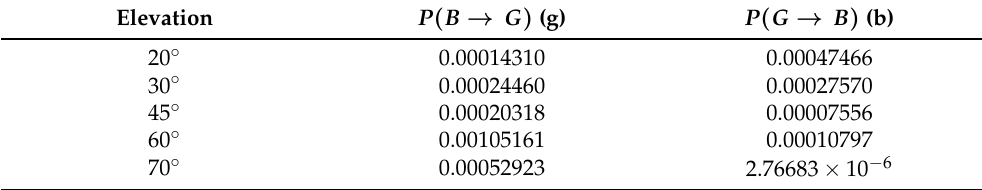
Table 2. Satellite link state transition probabilities for the dense urban area in France at 2.2